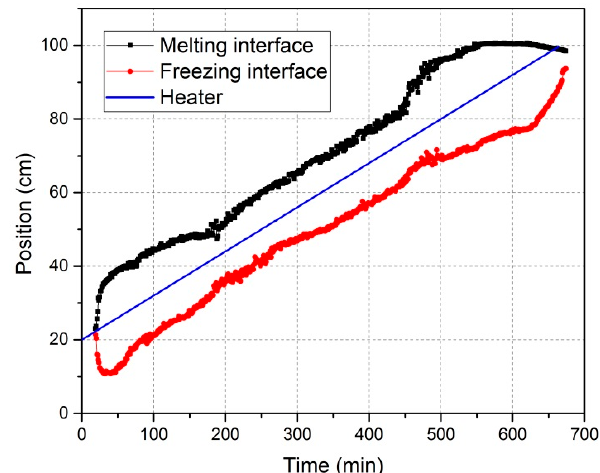
Figure 4. Positions of the melting interface, freezing interface, and heater against time for the experiment with 11 kW-1.2 mm/min, showing that the freezing- and melting interfaces moved nonlinearly.